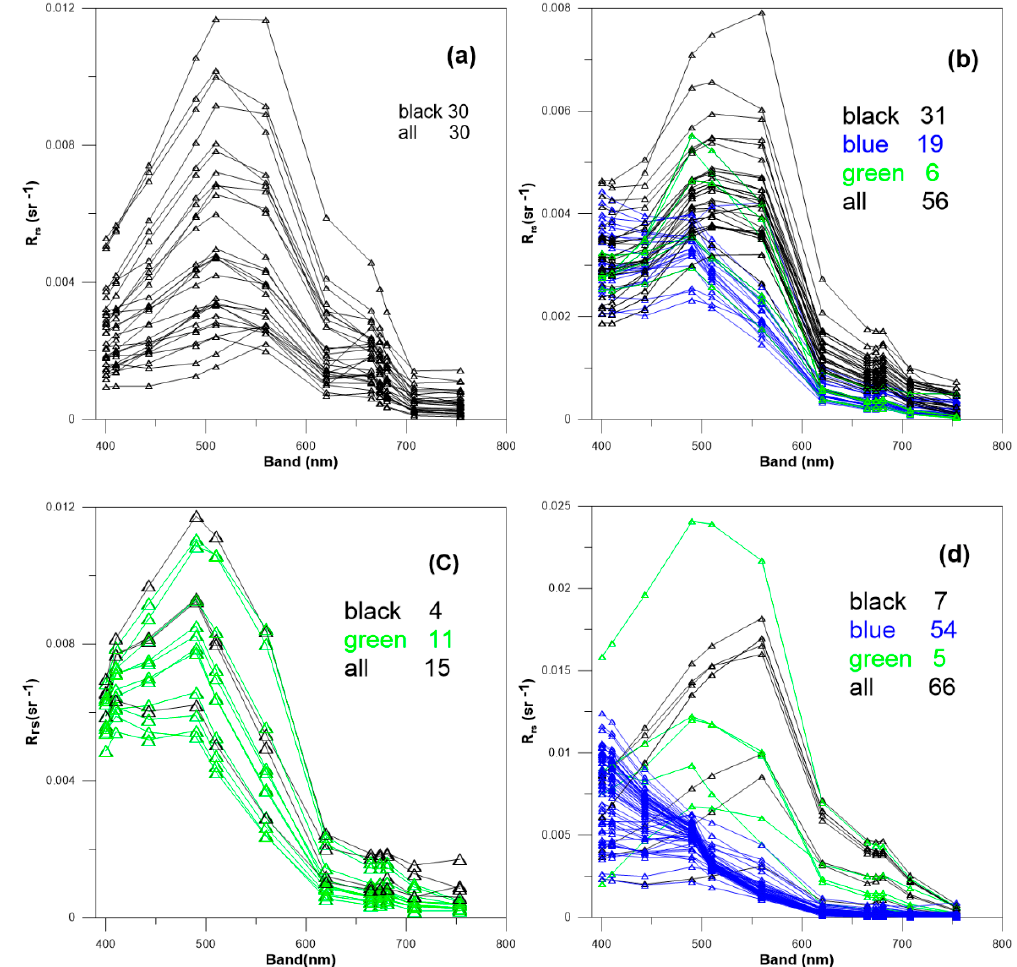
Figure 4. In-situ R rs spectra at OLCI bands: ( a ) in the BoS, ( b ) in the YS, ( c ) in the PRE, ( d ) in the ECS&SCS. The blue spectra correspond to the open ocean, the black spectra to the turbid waters, the green corresponds to intermediate waters between open ocean and turbid waters.